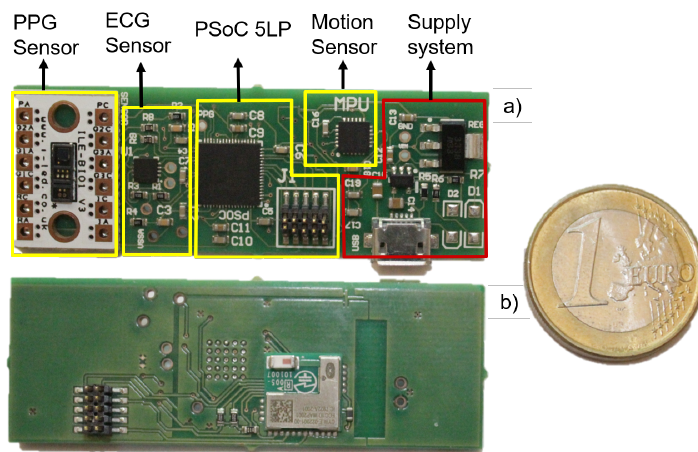
Figure 6. Prototype Circuit Board (PCB) of prototype device: ( a ) top side; ( b ) bottom side with the communications system.